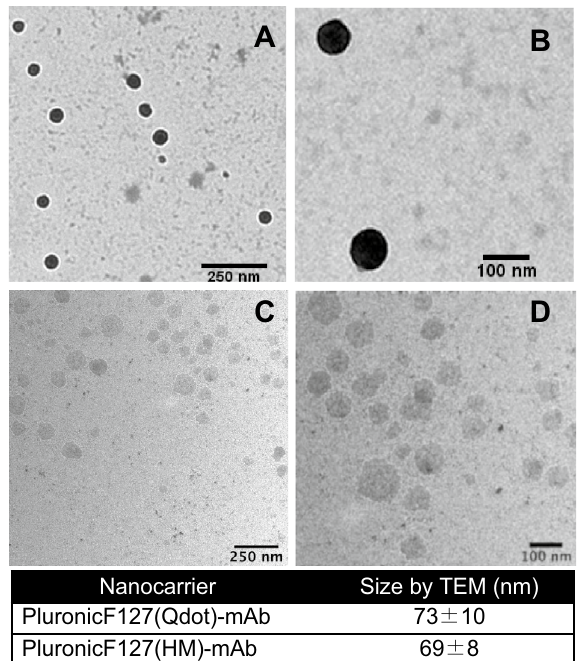
Figure 3. Antibody conjugated cargo loaded nanocarrier diameter was measured 73 ± 10 nm for QDot loading and 69 ± 8 nm for HM loading. ( A , B ) TEM images of Pluronic F127(Qdot)-mAb. ( C , D ) TEM images of Pluronic F127(HM)-mAb HM harmine, TEM transmission electron